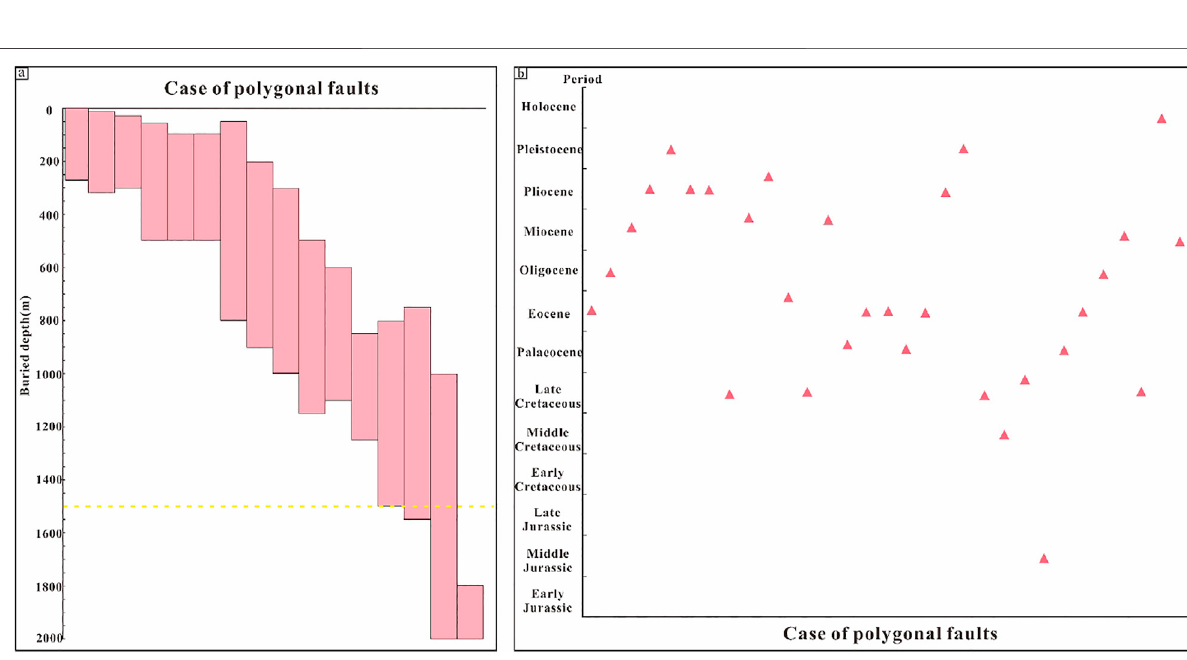
Frontiers in Earth Science |